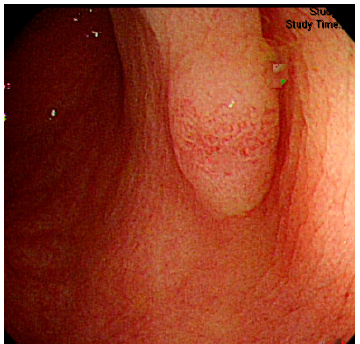
Figure 3. Small texture of polyp and intestinal wall.